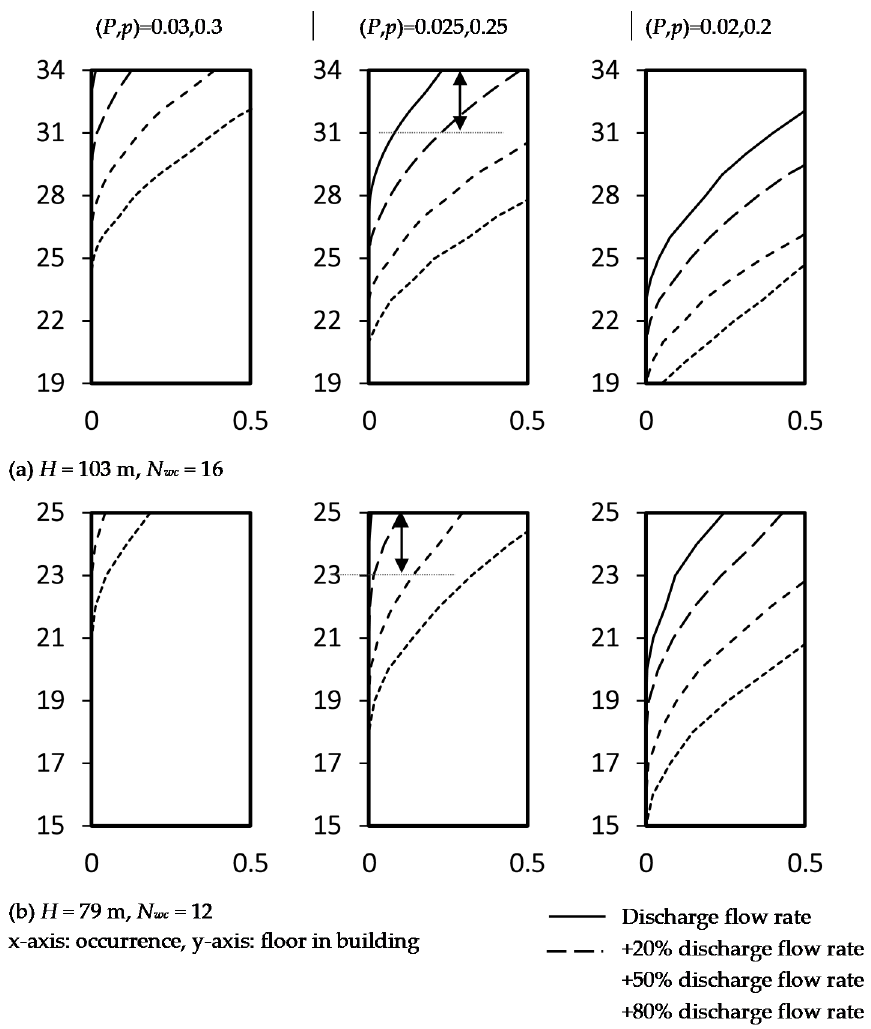
Figure 10. Sensitivity risk increment due to 20% more discharge flow rate in two example buildings. ( a ) Height H= 103 m; ( b ) height H= 79 m.